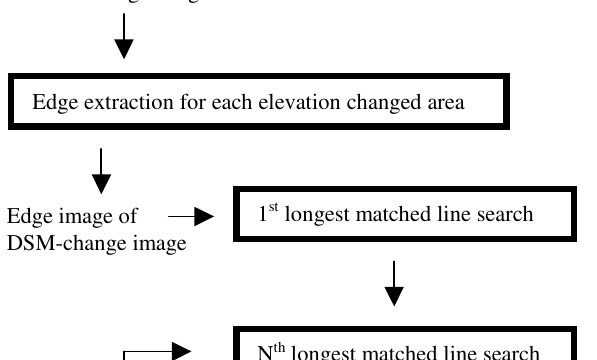
DSM-change image